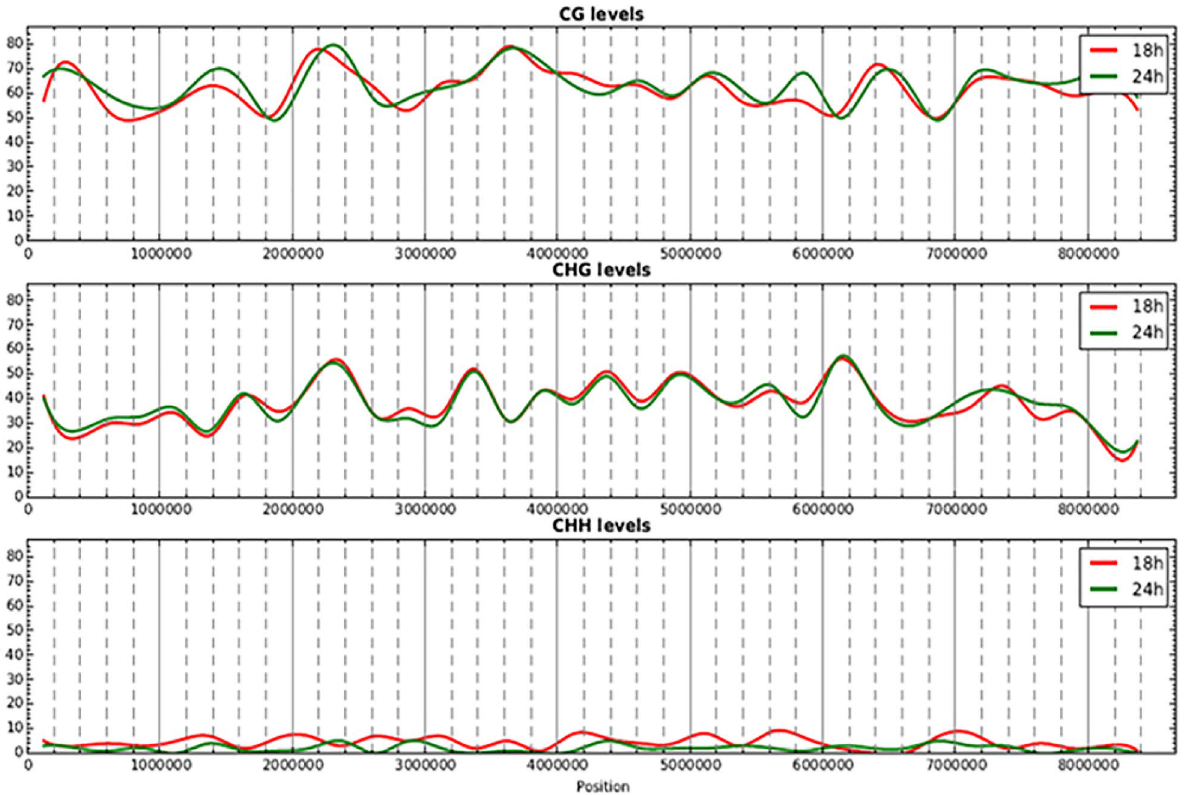
Figure 4. Methylation levels along the chromosome (250 kbp window) at 18 and 24 h of growth in the MG medium. Red and green lines correspond to the methylation levels at 18 h and 24 h, respectively.